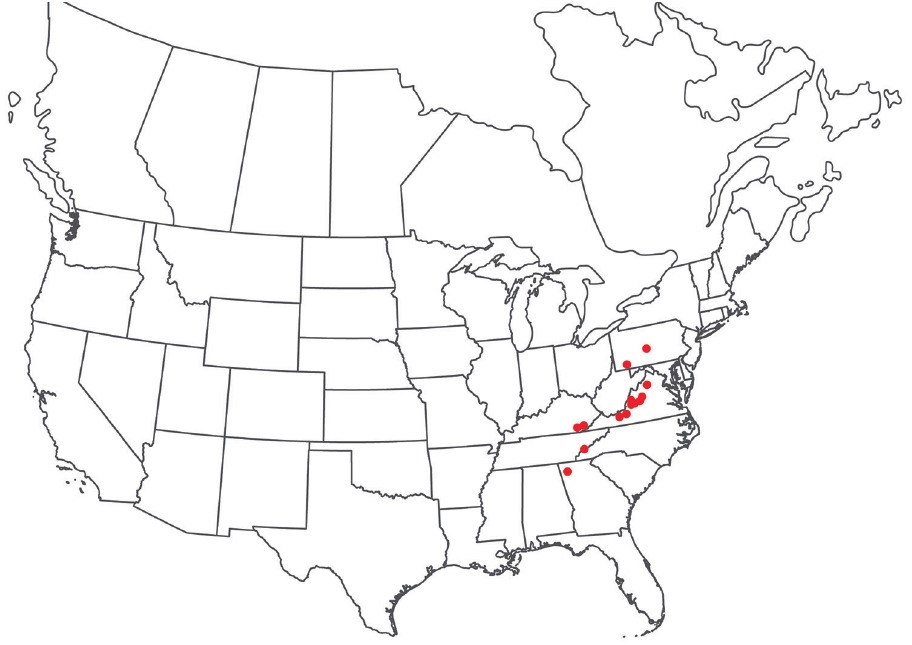
Figure 84. Torrenticola glomerabilis sp. n.